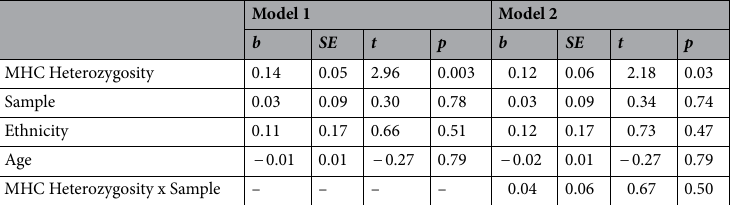
Table 1. Results of a multiple linear regression depicting the predictive relationship between MHC heterozygosity and relative pubertal development. b = unstandardized regression coefficient, SE = standard error, t = t -score, p = p -value.